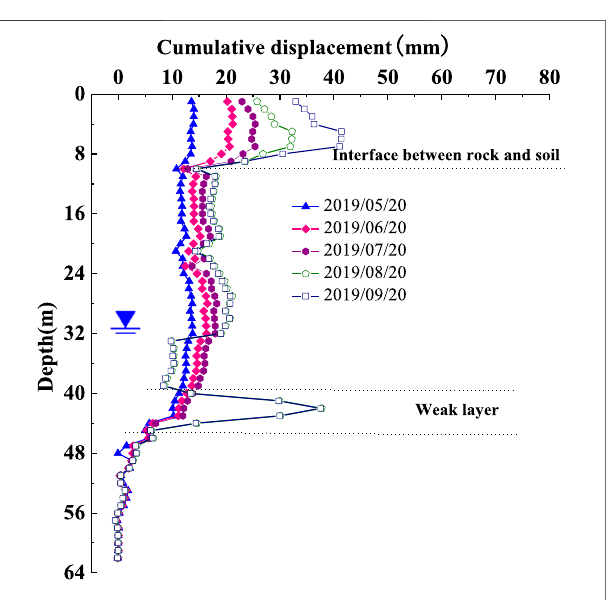
FIGURE 15 | Relationships between cumulative displacement and time obtainedfromalandslidecomposedofmulti-layerslidingzones.Thedatawas measured by the MEMS-based in-placement